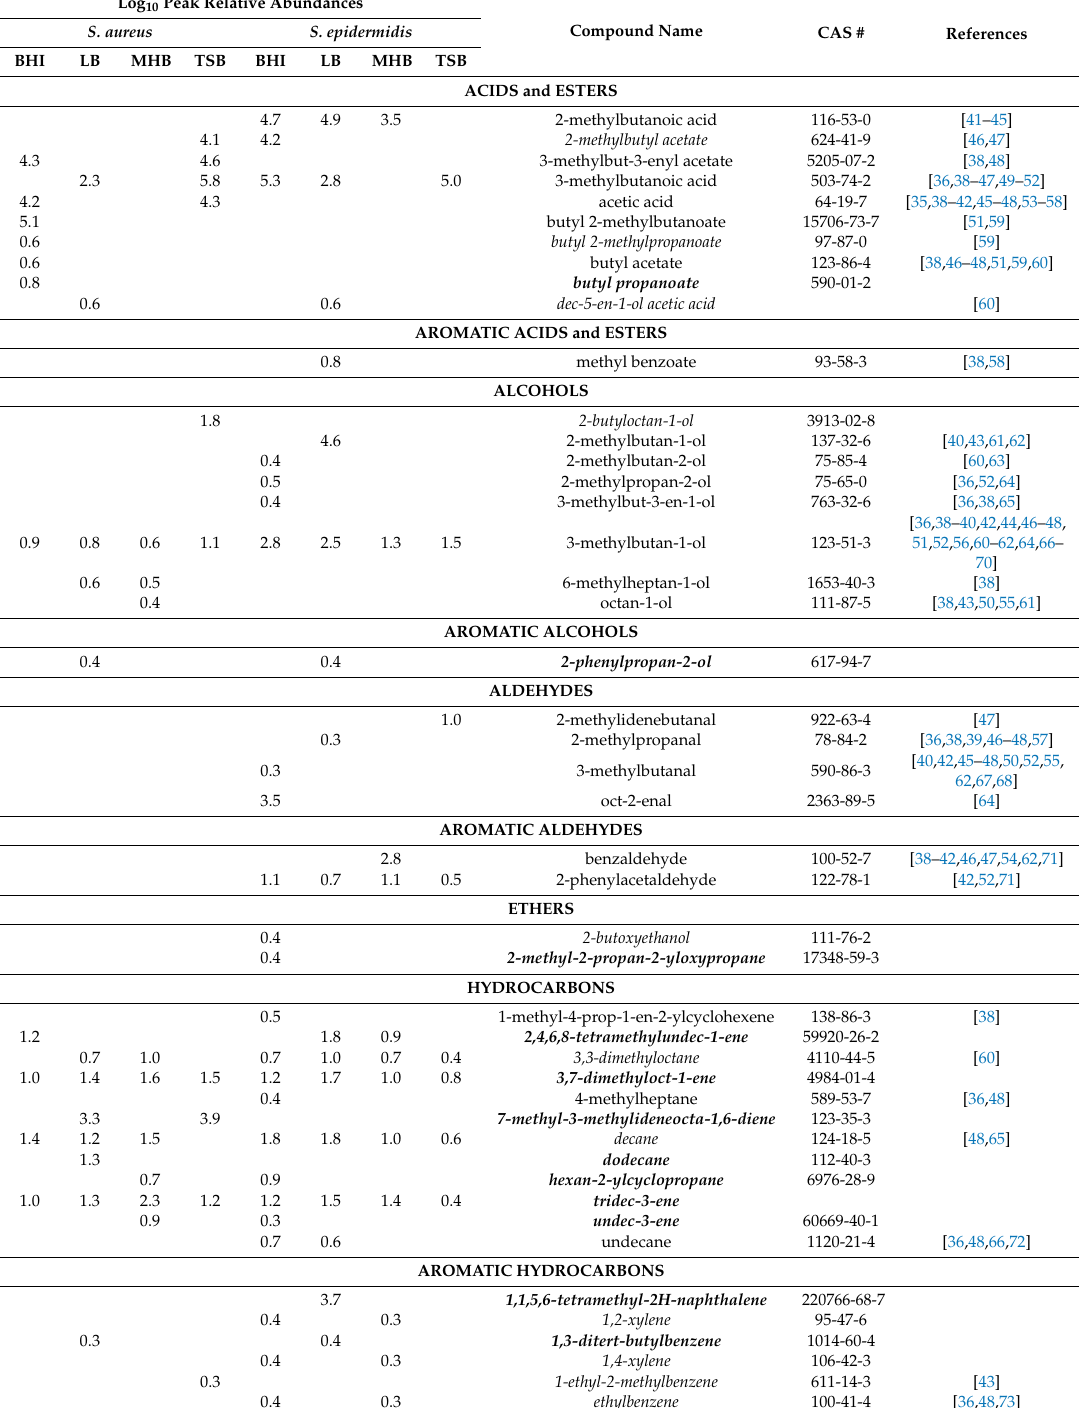
Table 1. Volatiles detected in the headspace of S. aureus or S. epidermidis cultured in brain heart infusion (BHI), lysogeny broth (LB), Mueller Hinton broth (MHB), or tryptic soy broth (TSB). Peak relative abundances are reported as the Log 10 fold change of the mean peak intensity in the bacterial culture versus the mean intensity in the corresponding medium control. Italicized volatiles have not been previously reported for S. aureus or S. epidermidis , and bolded italicized volatiles have not been previously reported for bacteria. Additional data for these volatiles are available in Table